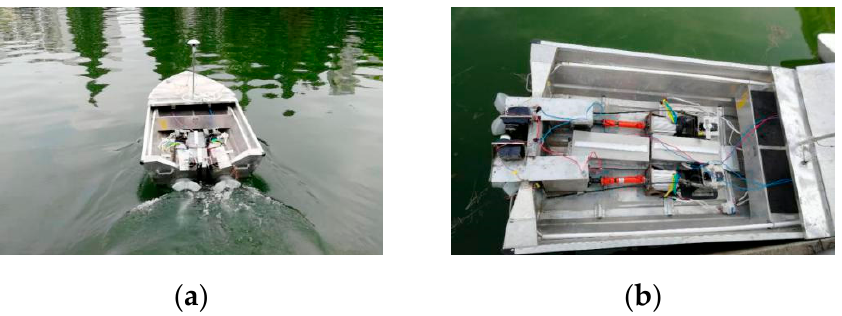
Figure 2. Twin water-jets water unmanned surface vehicles ( a : back view of USV; b : top view of USV). Table 2. Particulars of the USV.